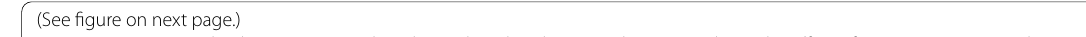
group(See figure on next Fig. 4 RANTES is involved in Pam3 CM-induced JNK phosphorylation, and TNF-α mediates the effect of Pam3 CM on JNK and NF-κB phosphorylation. A AVICs are treated with Pam3 CM for 0.5, 1, 2 or 4 h. Representative immunoblots and densitometric data show that Pam3 CM induces the phosphorylation of p38, ERK1/2, JNK and NF-κB. *P < 0.05 vs. 0 h. Data are presented as mean donor valves in each group. B AVICs were treated for 1 h with Pam3 CM pre-incubated with neutralizing antibodies (10 μg/ml) against TNF-α, RANTES or both. Neutralization of TNF-α attenuated the effect of Pam3 CM on JNK and NF-κB phosphorylation. Neutralization of RANTES attenuated the effect of Pam3 CM on JNK phosphorylation. *P < 0.05 vs. untreated control. # P < 0.05 vs. Pam3 CM or Pam3 CM treated with non-immune IgG. Data are presented as mean SEM. n 5 cell isolates from distinct donor valves in each ± =